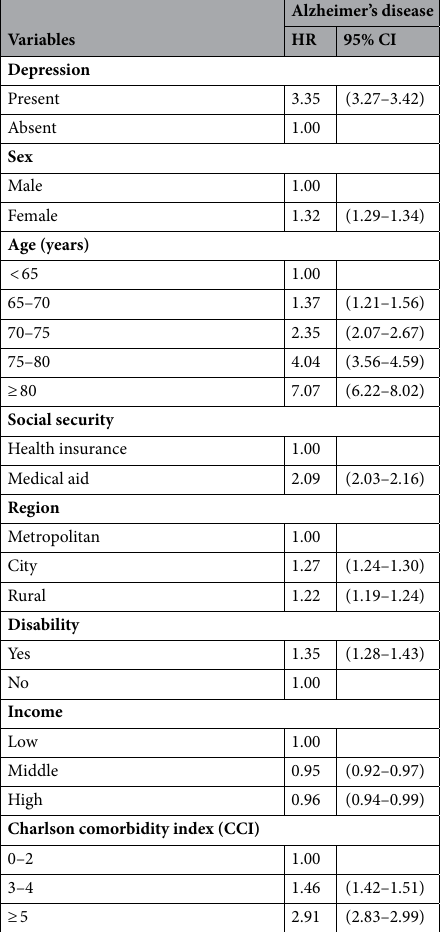
Table 2. Cox proportional hazards regression analysis results for the association between depression and Alzheimer’s disease